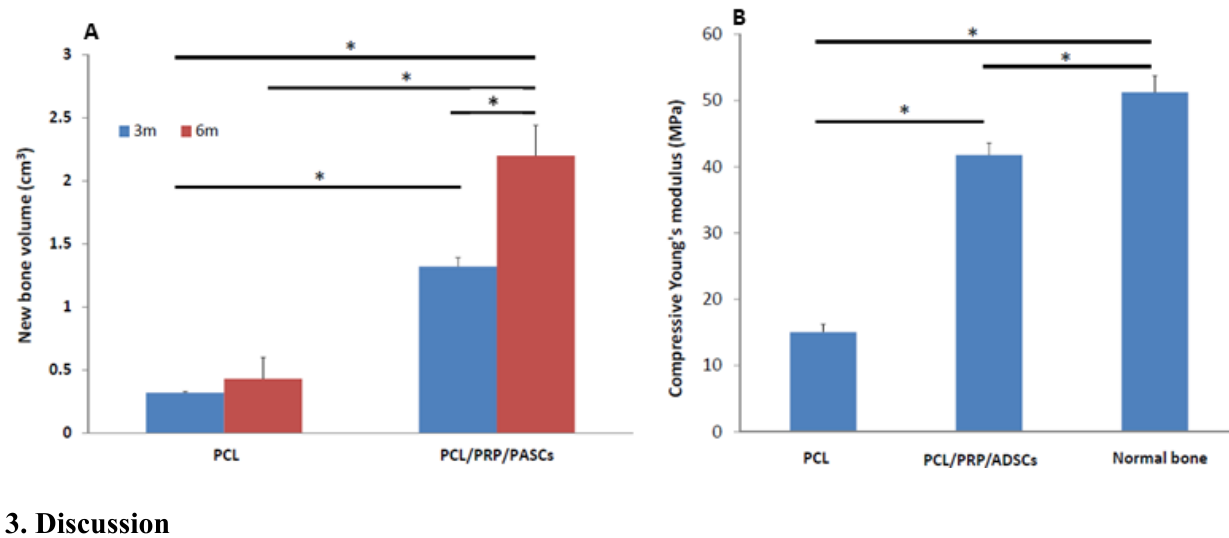
Figure 6. ( A ) The new bone volume calculated from 3D CT images in acellular PCL scaffolds and PCL/PRP/PASCs constructs 3 and 6 months post-operation. ( B ) The compressive Young’s modulus of acellular PCL scaffolds and PCL/PRP/PASCs contructs 6 months post-operation. * p <